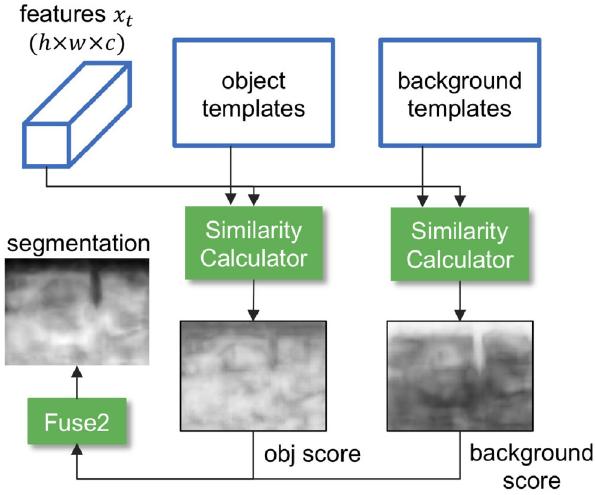
Similarity calculator SC module. For each frame f t , the encoder E generates a feature tensor x t . The feature vector corresponding to each region i in f t is x t ( i ). We compute the cosine similarity between each feature vector of the x t ( i ) and the object/background features in the template list. The object/background score map is the average of the top K similarity scores. The fusion module Fuse2 fuses the object/background score maps to give a segmentation